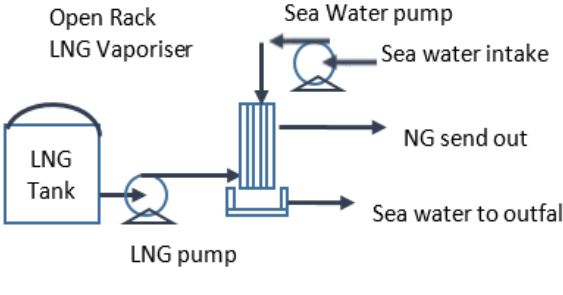
Figure 4. Open rack vaporizer.